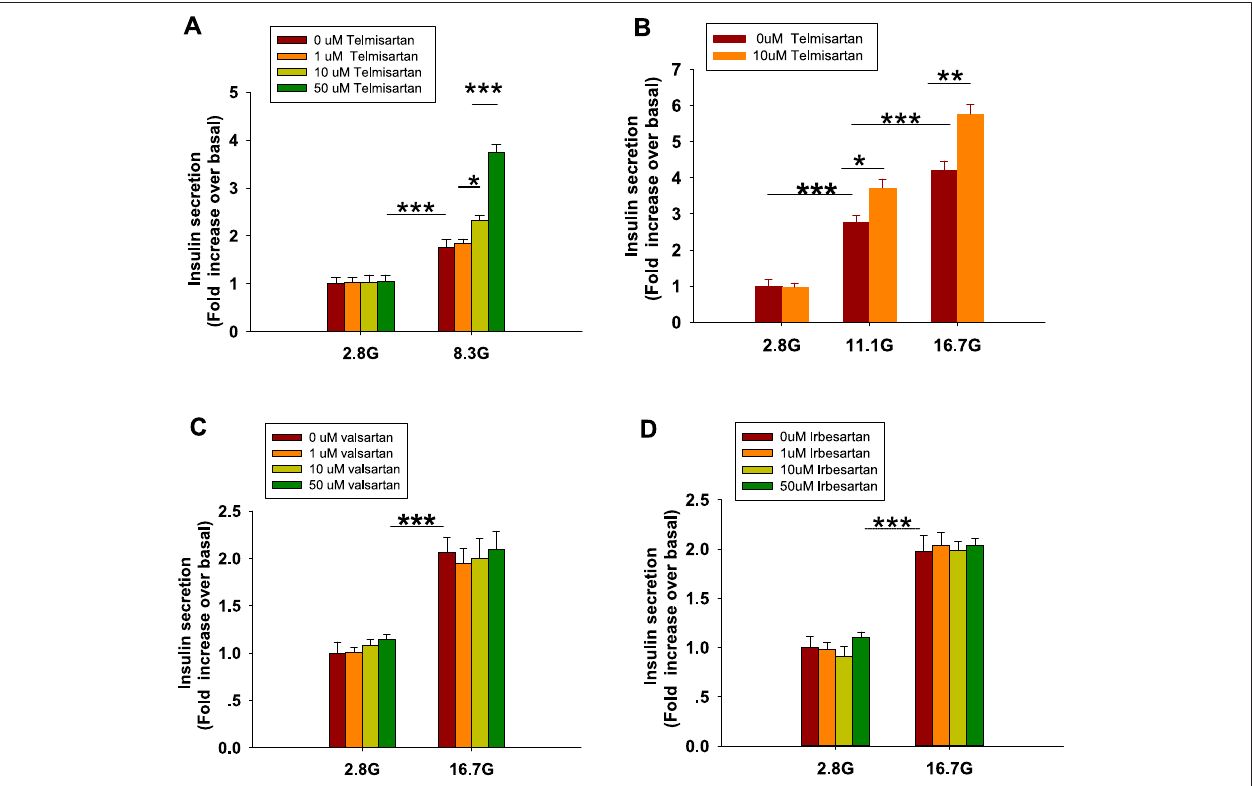
FIGURE 1 | Only telmisartan among the three ARBs potentiated insulin secretion in rat islets ( n (cid:1) 7 tubes of islet). (A) Rat islets were treated with various doses (1, 10, and 50 μ M) of telmisartan under 2.8 and 8.3 mM glucose (denoted as 2.8 G and 8.3 G) conditions. (B) Islets were treated with 10 μ M telmisartan under different glucose concentrations (2.8, 11.1, and 16.7 mM). (C , D) Rat islets were treated with various doses (1, 10, and 50 μ M) of valsartan or irbesartan under 2.8 and 16.7 mM glucose conditions. The islets compared between the groups in each graph are collected from the same animal. All results are normalized to basal secretion at 2.8 G, and reported as the means ± SEM. Statistical differences among three or more groups were compared using one-way analysis of variance (ANOVA) and Student – Newman – Keuls method post hoc analysis. Statistical differences between two groups (with or without telmisartan) under the same glucose condition in (B) were determined using an unpaired two-tailed Student ’ s t test. * p < 0.05, ** p < 0.01, *** p <